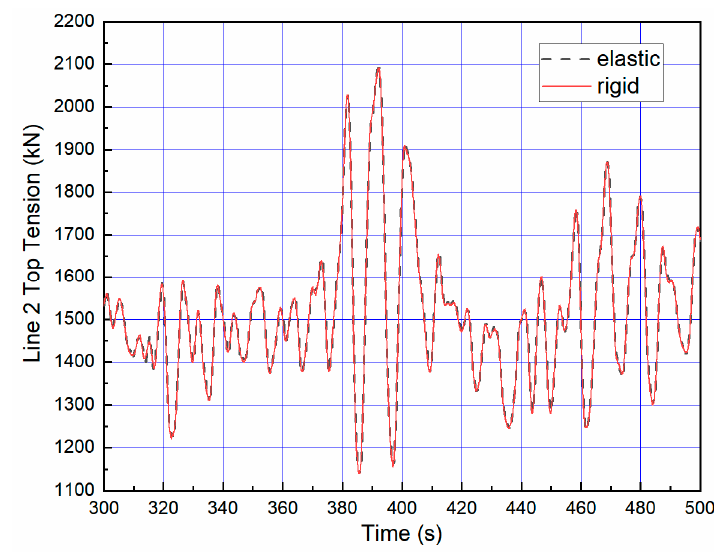
Figure 13. Comparison of line 2 top tension (rigid and flexible tower / blades). Table 4. Comparison of statistical data (slack mooring line).